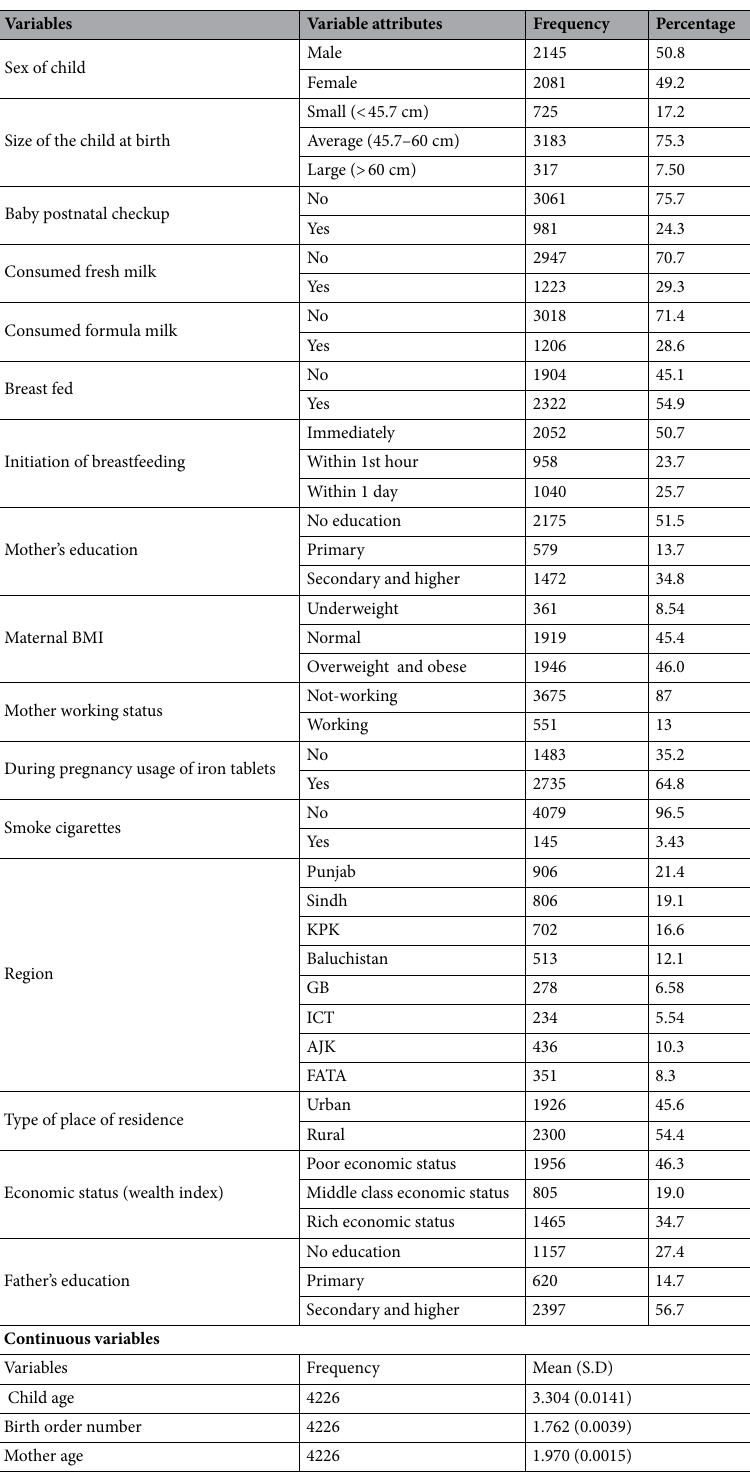
Table 2. Descriptive statistics of explanatory variables—child, maternal and societal characteristics for malnutrition—Pakistan Demographic Health Survey (2017–2018). KPK Khyber Pakhtunkhwa, GB Gilgit Baltistan, ICT Islamabad Capital Territory, AJK Azad Jammu and Kashmir, FATA Federally Administered Tribal